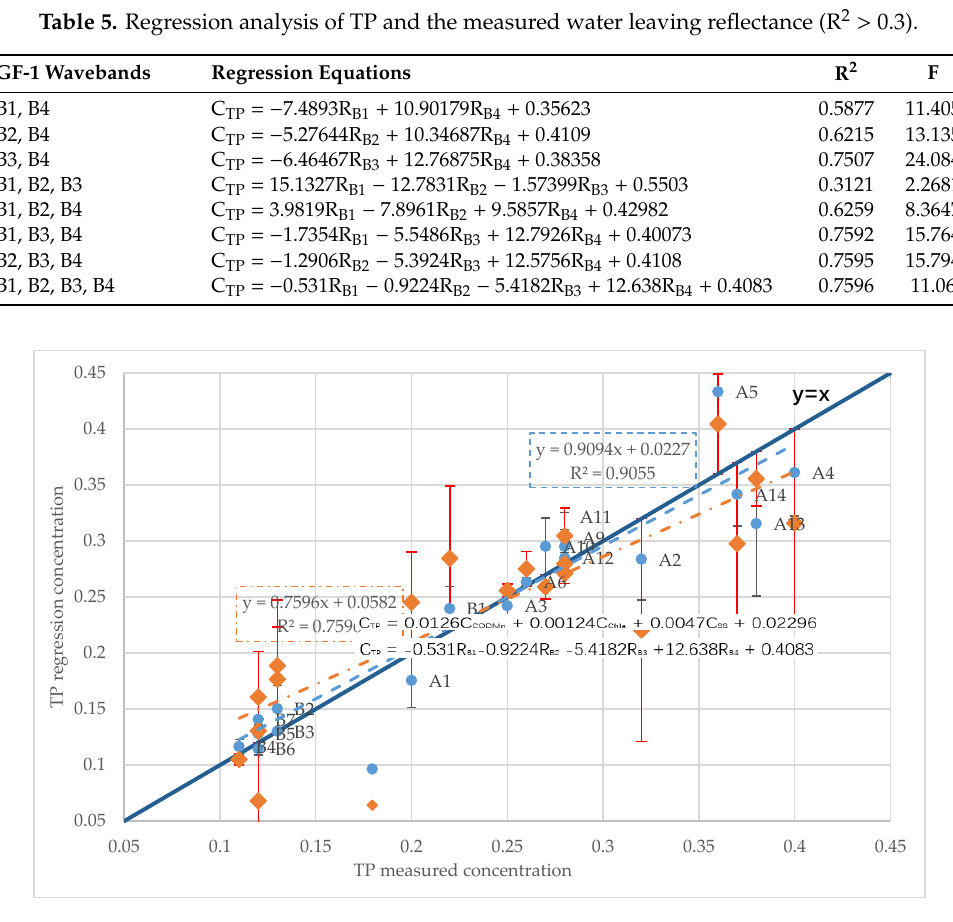
Figure 9. TP regression concentration of sampling sites.